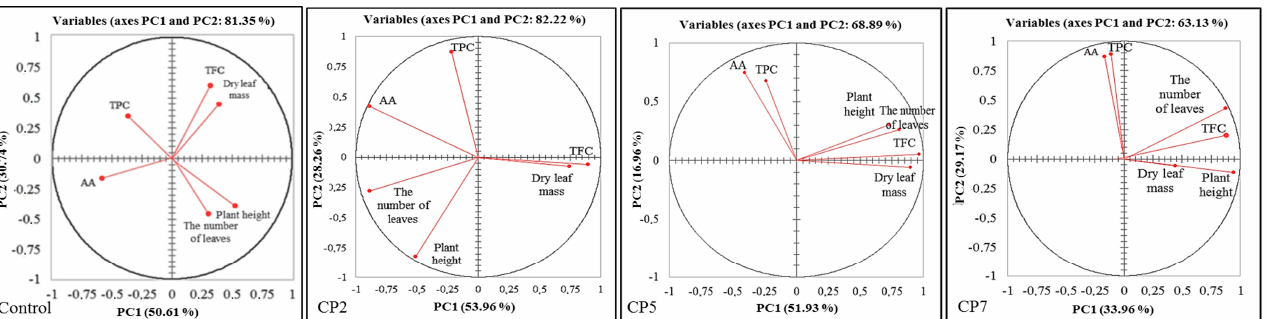
Figure 5. The correlation circles of the morphometric parameters (dry leaf mass, the number of leaves, plant height) and SG parameters (the concentrations of rebaudioside A (RebA) and stevioside (Stev), total concentration of SGs (RebA+Stev), ratio RebA/Stev in stevia leaves) of the control group and treatment groups (CP2, CP5 and CP7).